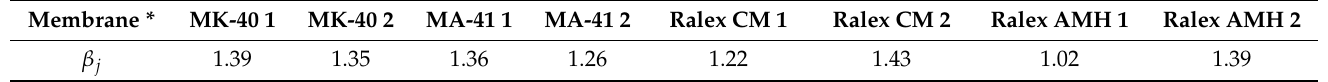
Table 4. Parameter β j values found for the studied ion-exchange